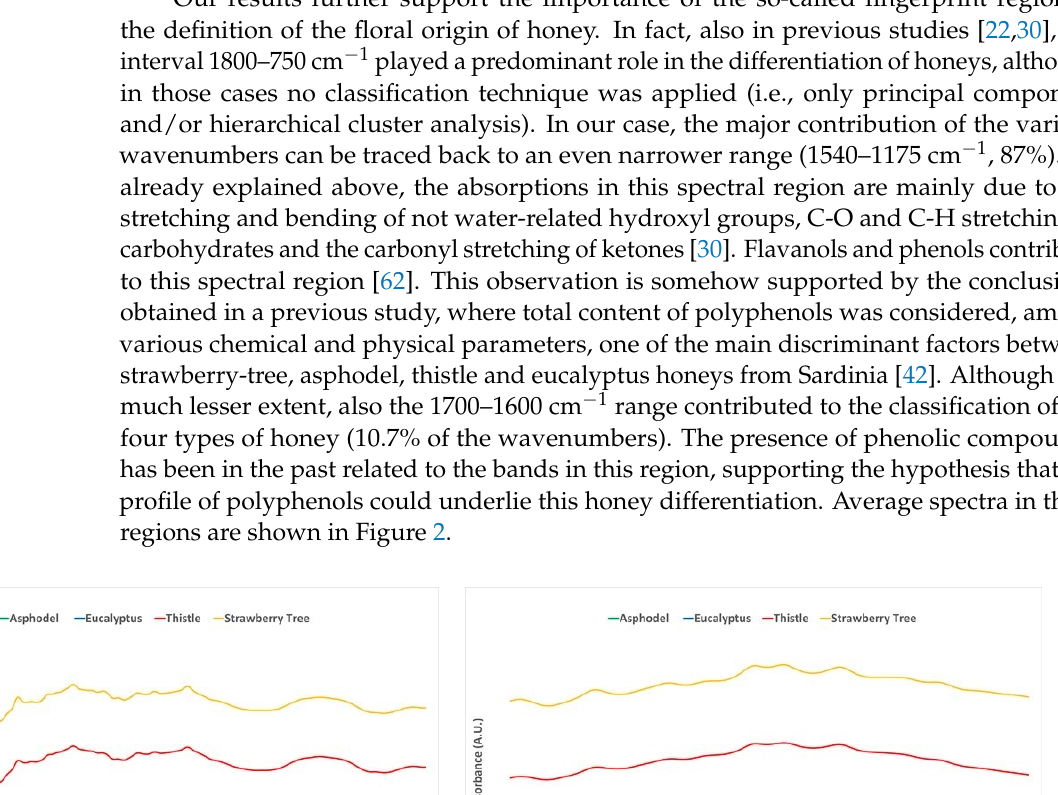
Figure 3. 2D visualization of unsupervised random forest. The unsupervised proximity information plotted in 2D shows how strawberry-tree honeys are clearly identifiable, being the corresponding cluster visibly distinguishable from the other three. This observation could be the evidence of the influence of the distinct chemical characteristics of strawberry-tree honey on the IR spectrum. In fact, this honey stands out from the other local honeys due to its extremely high polyphenol content, which constitutes the main reason for its nutraceutical properties. This observation is also supported by the high sensitivity value recorded for strawberry-tree honeys, very close to 100%. On the other hand, asphodel honeys showed the lowest sensitivity resulting as the